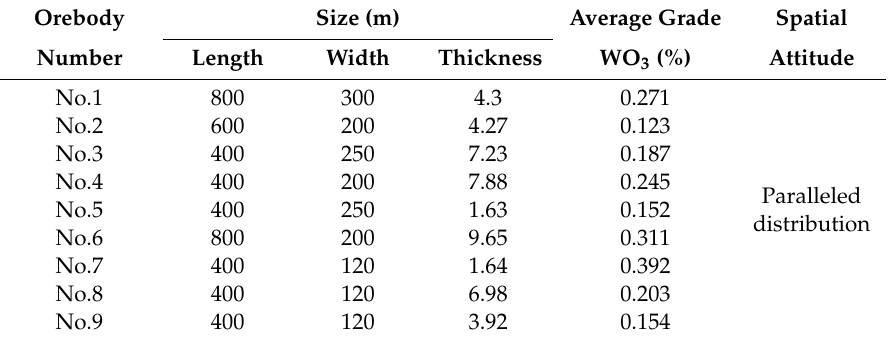
Table 1. Summary of main orebody characteristics in the Shangfang W deposit. Orebody Size (m) Average Grade